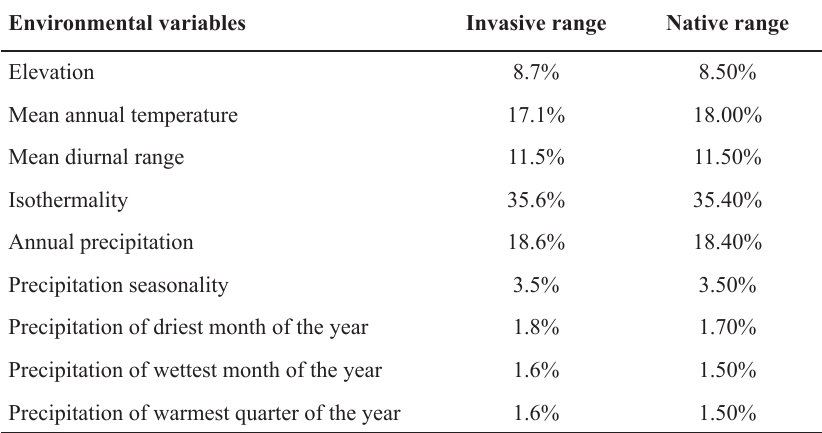
Table 2 – Environmental variables used to model the climatic niches of the Peruvian peppertree in its invasive range (Mexico) and native range (Peru and Bolivia) using PCA. The table also indicates the percent contribution of each variable to explain variance in the species distribution models (SDM) calibrated for the invasive and native range of the